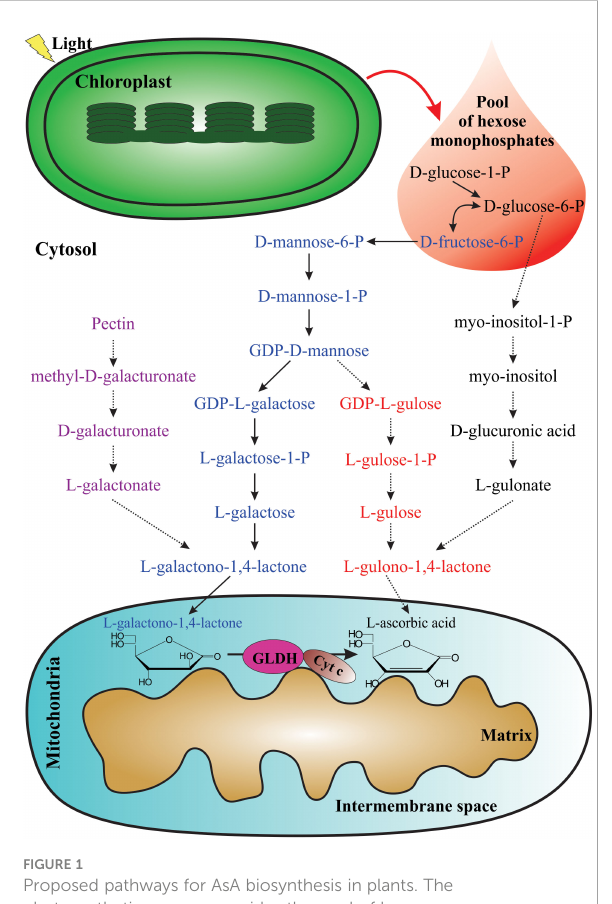
FIGURE 1 Proposed pathways for AsA biosynthesis in plants. The photosynthetic process provides the pool of hexose monophosphates as precursors for some AsA biosynthetic pathways. From left to right: D-galacturonic acid pathway (violet), L- galactose pathway (blue), L-gulose pathway (red), and myo-inositol pathway (black). The last enzymatic reaction for AsA biosynthesis occurs in the mitochondria.